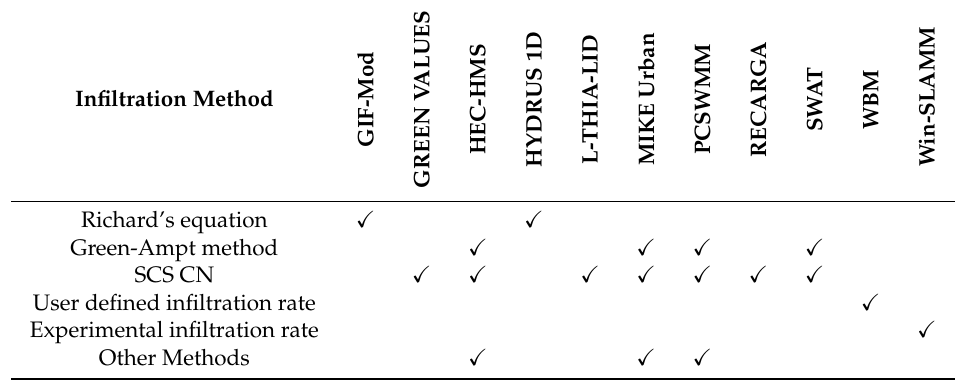
Table 9. Comparing the infiltration calculation method of the selected tools.